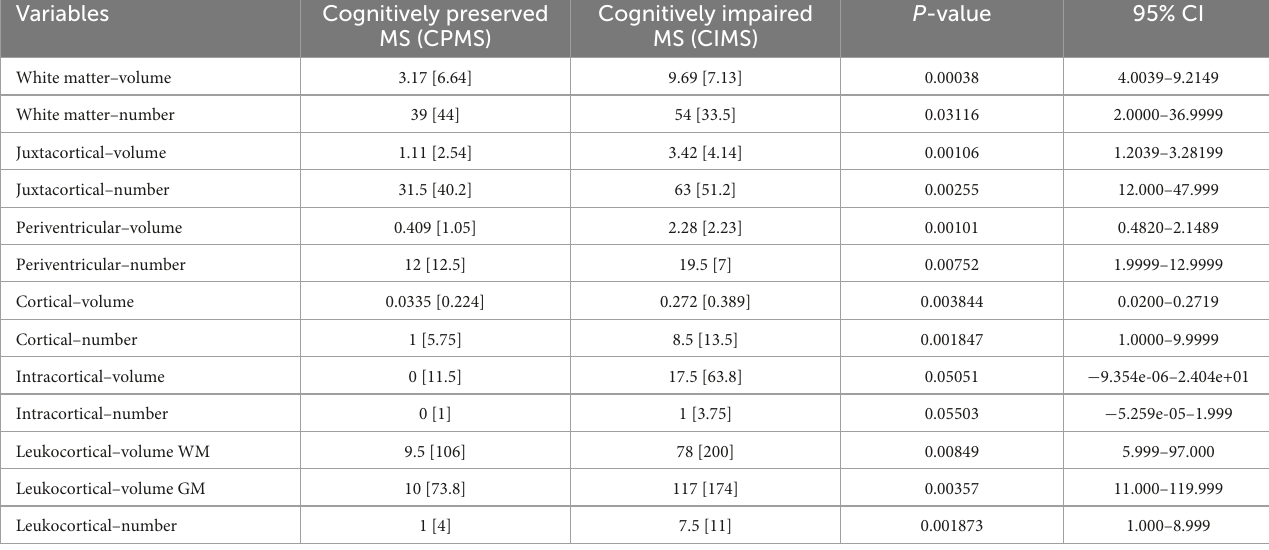
TABLE 3 Analysis of lesion types in patients with multiple sclerosis